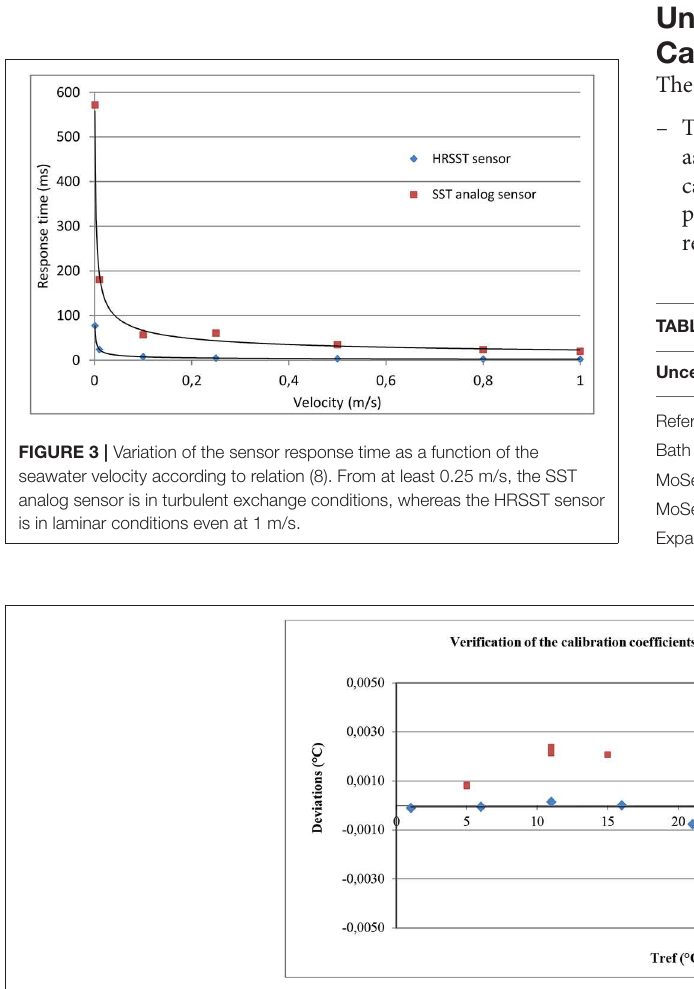
Frontiers in Marine Science |